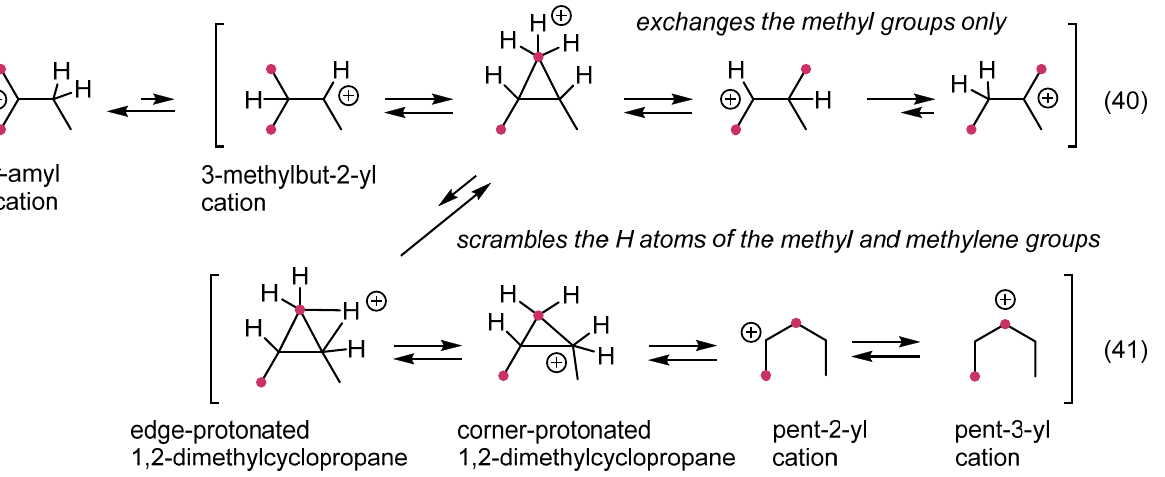
Scheme 14. Hydrogen- and carbon-atom scrambling in 2-methylbut-2-yl (tertioamyl) salt in a super- ionizing medium (SbF 5 /SO 2 ClF).